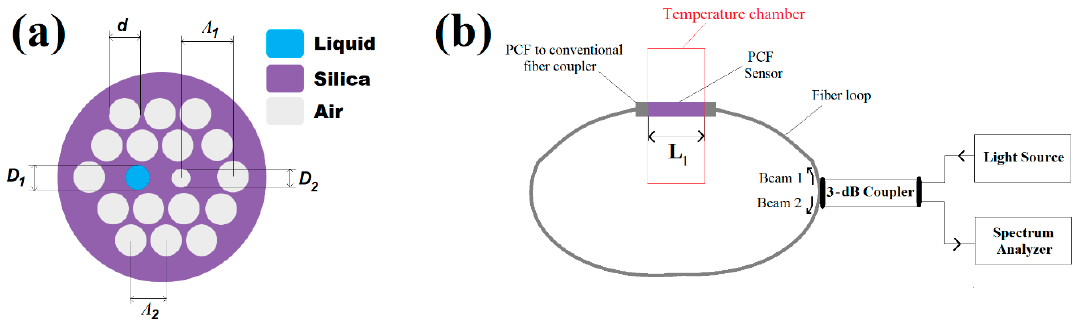
Figure 1. ( a ) Cross section of the selectively liquid-filled photonic crystal fibers (PCF) with hole diameter d , two modified-position holes with diameters D 1 and D 2 , modified-location hole pitch Λ 1 , and nonmodified-location hole pitch Λ 2 . ( b ) The schematic of the potential experimental setup of the PCF sensor in a Sagnac interferometer.